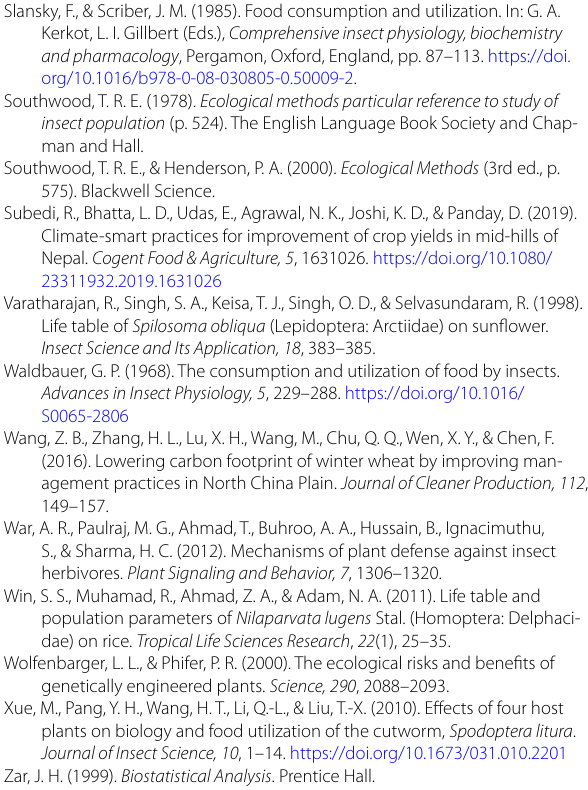
pods in agriculture . CRC Press. Pedigo, L. P., & Higley, L. G. (1992). A new perspective of the economic injury level concept and environmental quality. American Entomology, 38 , 12–21.